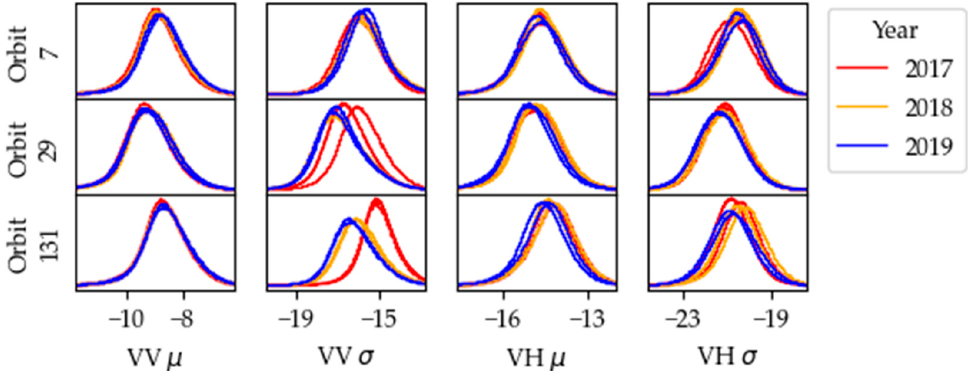
Figure 8. Statistical distribution for pixels labeled as forest in the validation sample disaggregated by year (color) and sub-swath (one line per sub-swath).